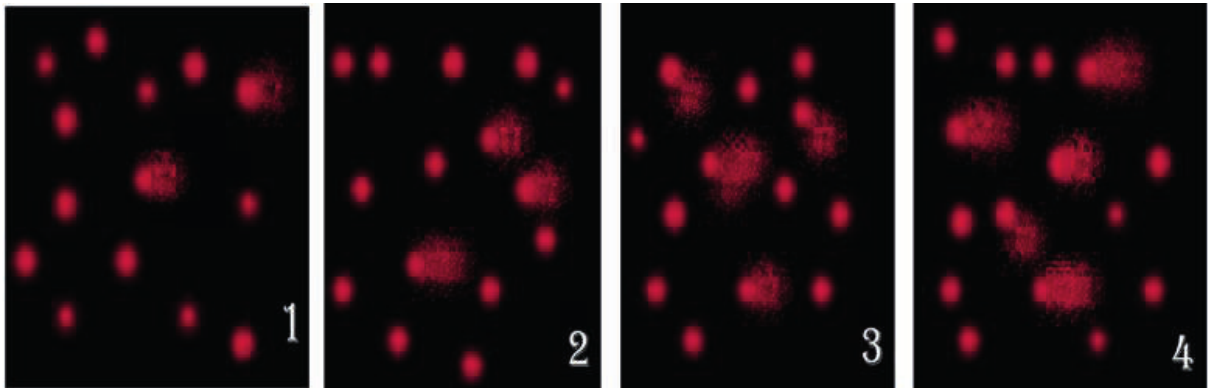
Figure 5. Comet nuclei prepared by Comet assay show the variable extent of nuclear DNA damage in the nuclei isolated from non-exposed and EMR exposed Zea mays for days of exposure times (Ex-1, Ex- 3,and Ex-5). Images 1–4 represented the days of exposure times (Ex-0, Ex-1, Ex-3,and Ex-5), respectively.